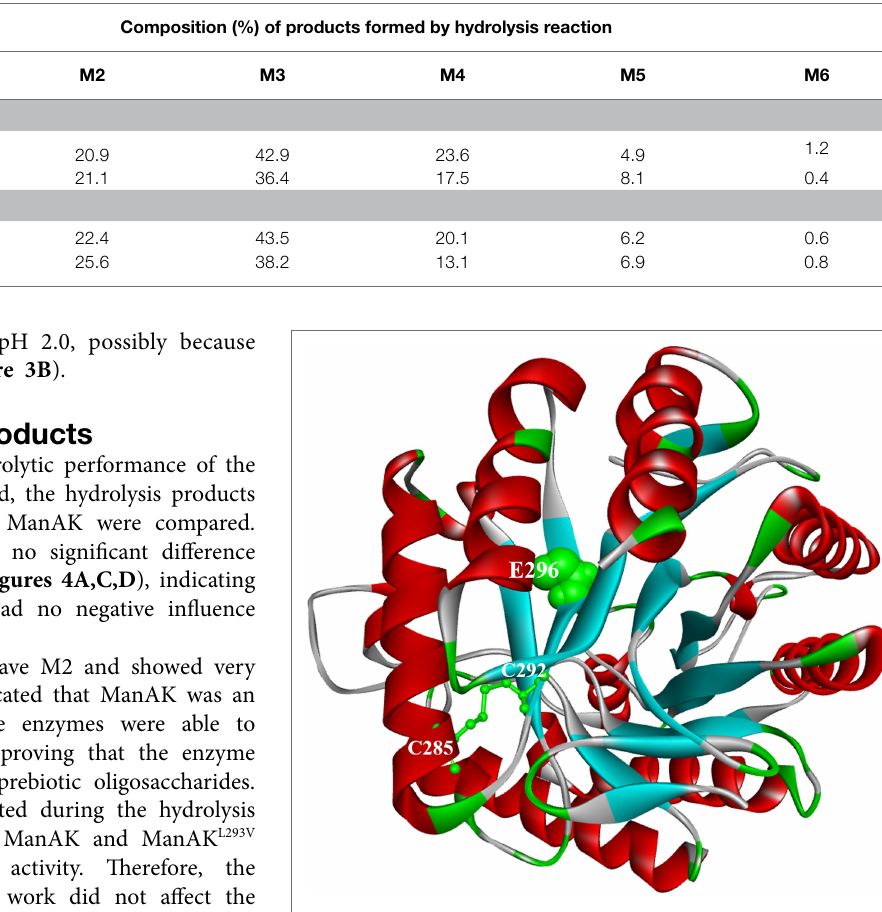
FIGURE 5 | Docking analysis and overall structure of ManAK. The catalytic region around E296 is illustrated in ball forms and colored in green. The disulfide bond formed between C292 and C285 is shown as stick models and colored in